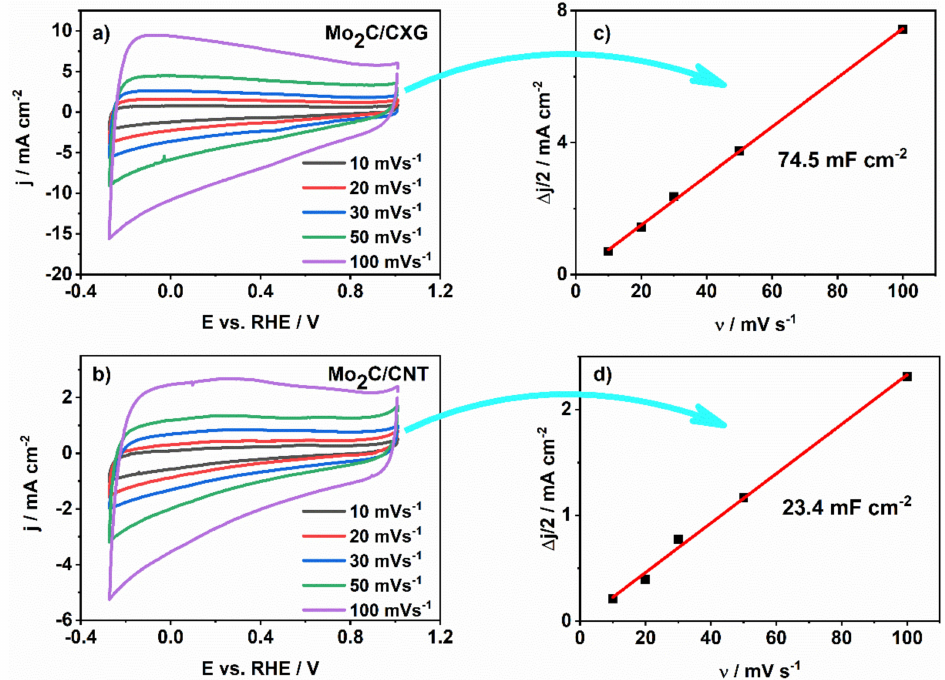
Figure 3. ( a , b ) Cyclic voltammograms of Mo 2 C / CXG and Mo 2 C / CNT in 6 M KOH at di ff erent scan rates; ( c , d ) specific capacitance versus scan rate, calculated from the corresponding cyclic voltammograms for each